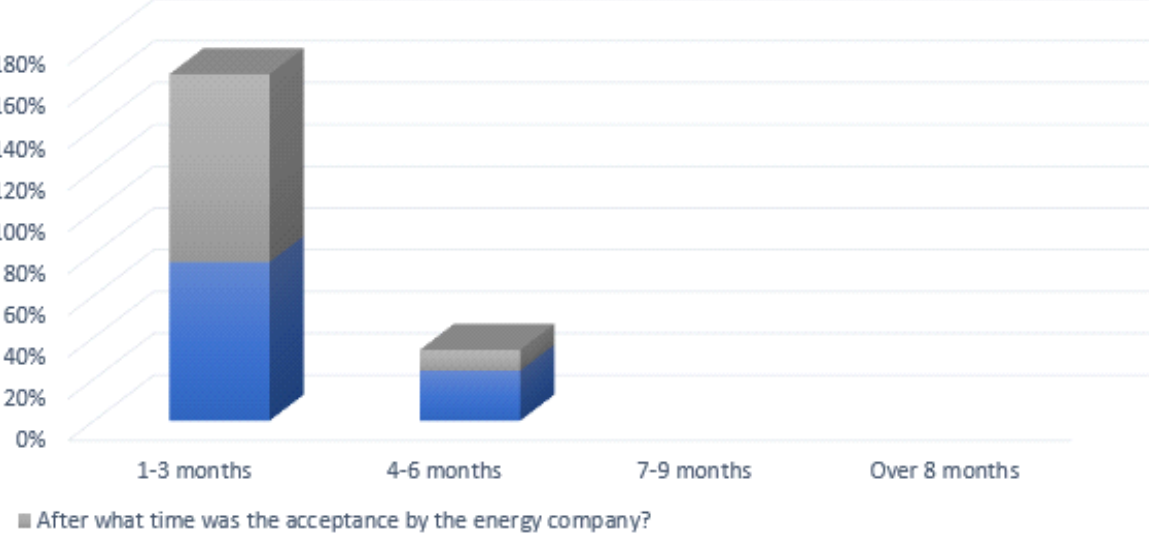
Figure 5. Duration of the decision-making process for purchasing a photovoltaic installation.